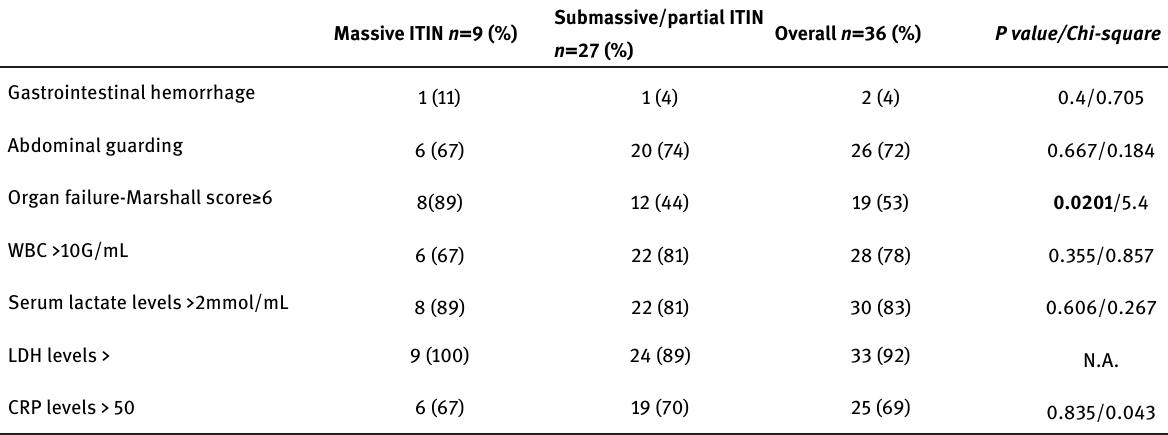
Table 3: Specific clinical and laboratory univariate analysis